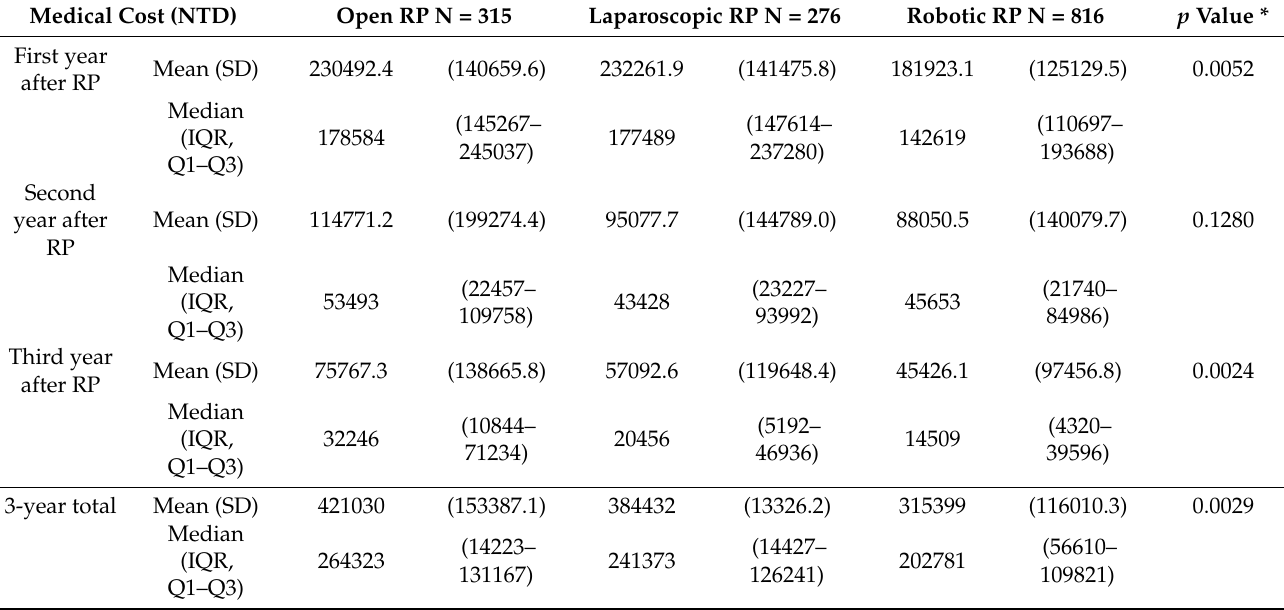
Table 4. Generalized linear mixed model of medical reimbursement for urinary diseases or surgical complications stratified by open, laparoscopic, and robotic